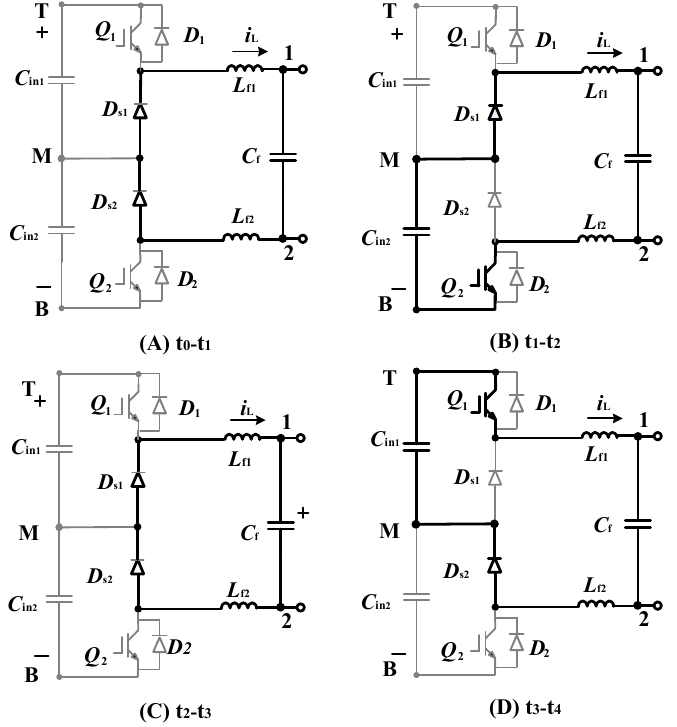
Figure 7. Operating stages and equivalent circuits for D < 0.5.